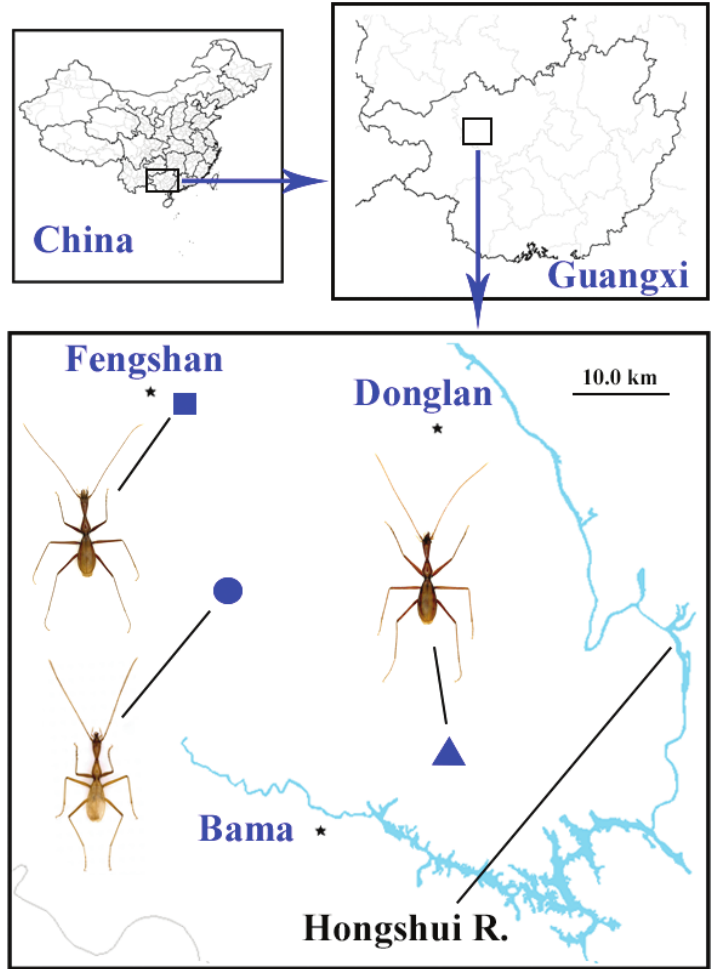
Figure 1. Range of the subgenus Dongodytes (s. str.) Deuve, 1993 (square = Dongodytes (s. str.) grandis , circle = Dongodytes (s. str.) fowleri , and triangle = Dongodytes (s. str.) tonywhitteni sp.